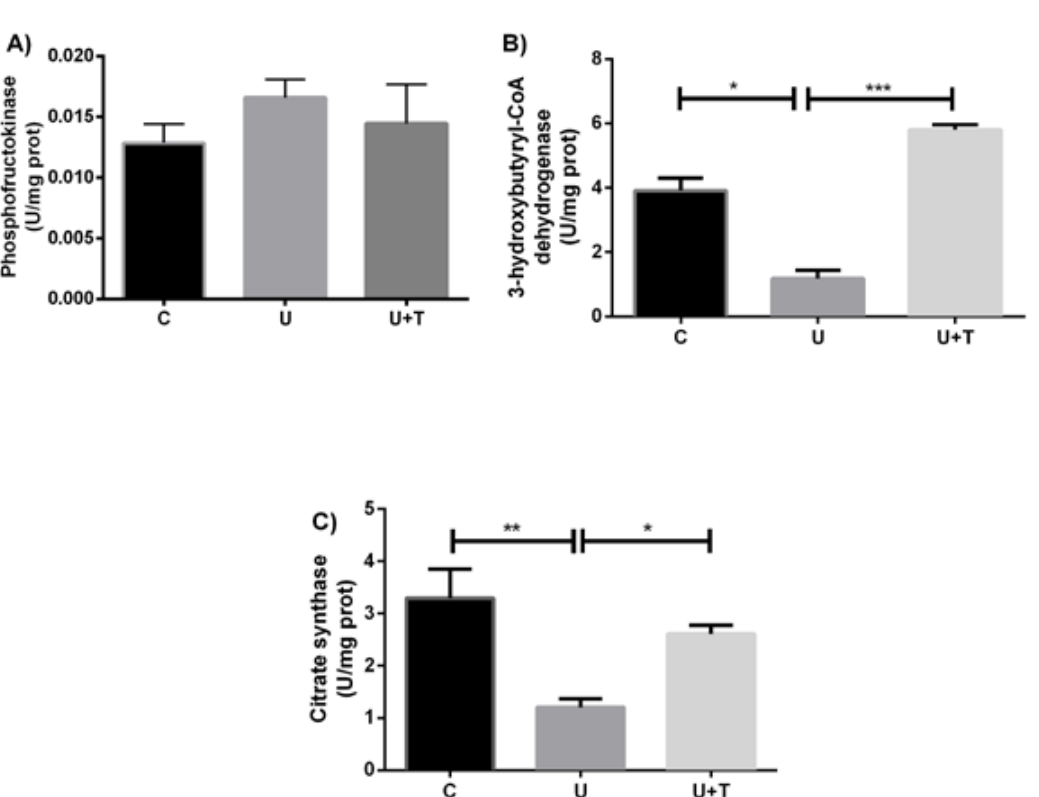
Figure 3: Effect of maternal low-protein diet and moderate physical training on cardiac metabolism. Enzymatic activities of Phosphofructoki- nase-PFK (A); 3-hydroxybytyryl-CoA dehydrogenase- β -HAD (B) and Citrate synthase (C) in male offspring at 120 days of life. C= Control group; U= undernourished group; U+T= undernourished plus 8 weeks of moderate physical training group. Data are shown as mean + SEM for 4-6 animals per group. * p <0.05; ** p <0.01; *** p